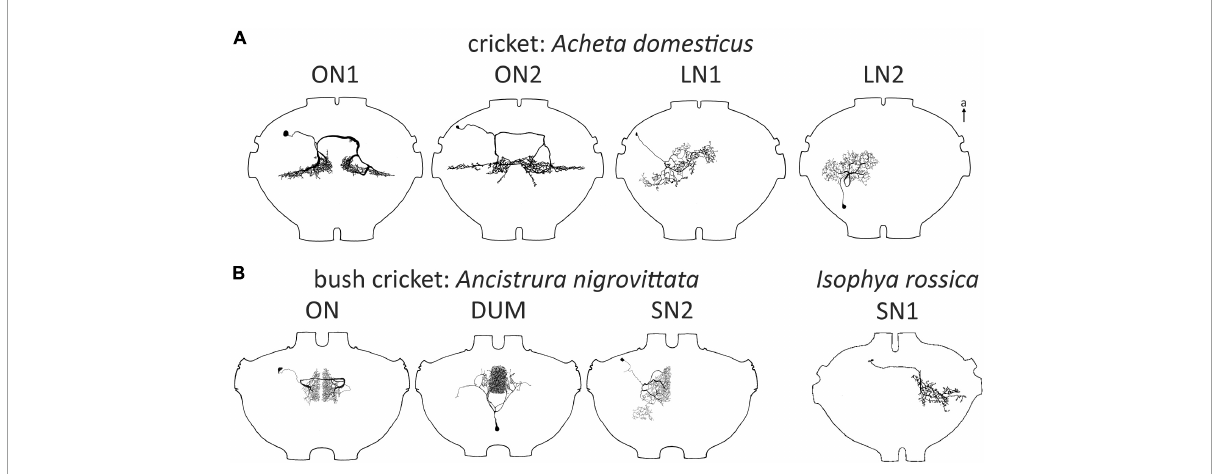
FIGURE1 Local auditory neurons in crickets (A) and bushrickets (B) . All types also in the bush cricket A. nigrovittata except for SN1 described in Isophya rossica , which has not been described in any other Ensiferan. All ganglia of similar size but not exactly drawn to scale for better comparability. a, anterior; ax, axon. LN1, LN2 redrawn with permission after Stiedl et al. (1997), SN1 redrawn after Zhantiev and Korsunovskaya (1990b).